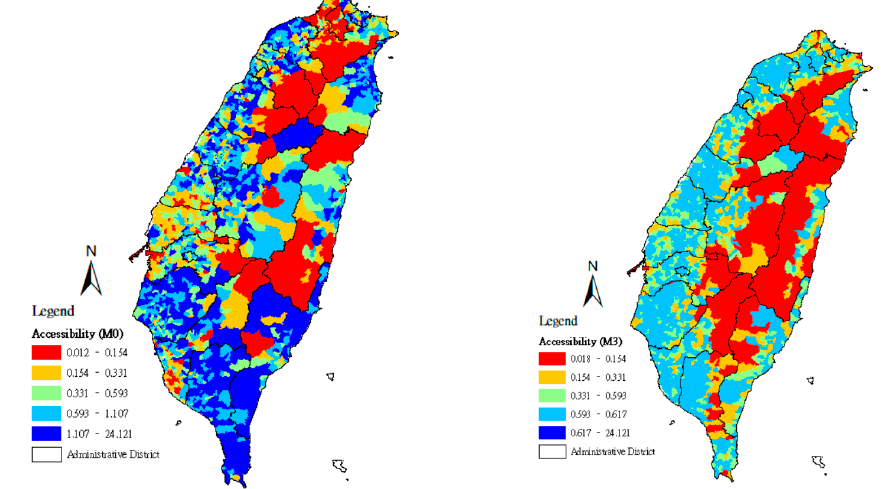
Figure 3. Accessibility score of community care stations in Taiwan using methods M0 and M3.